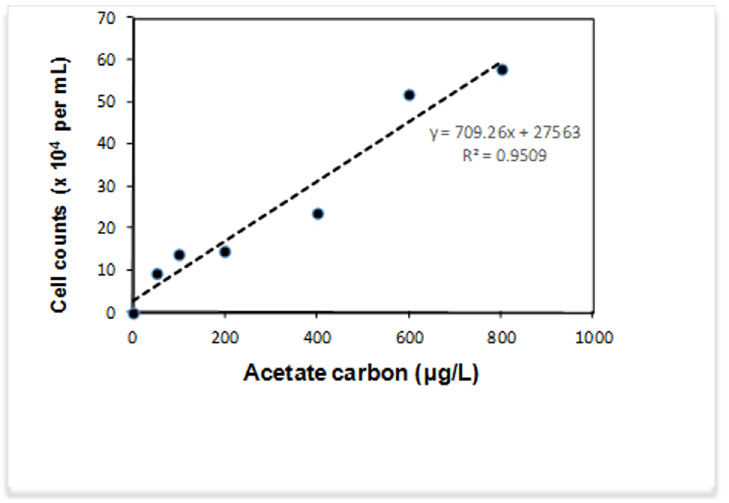
Fig 4. Cell counts for growth of GFP-P17 cells on a defined carbon source (sodium